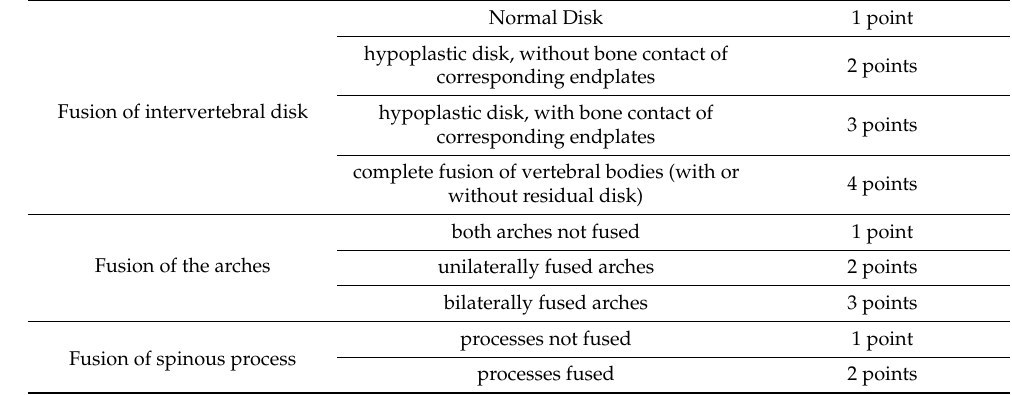
Table 1. Degree-of-fusion score (sum score).